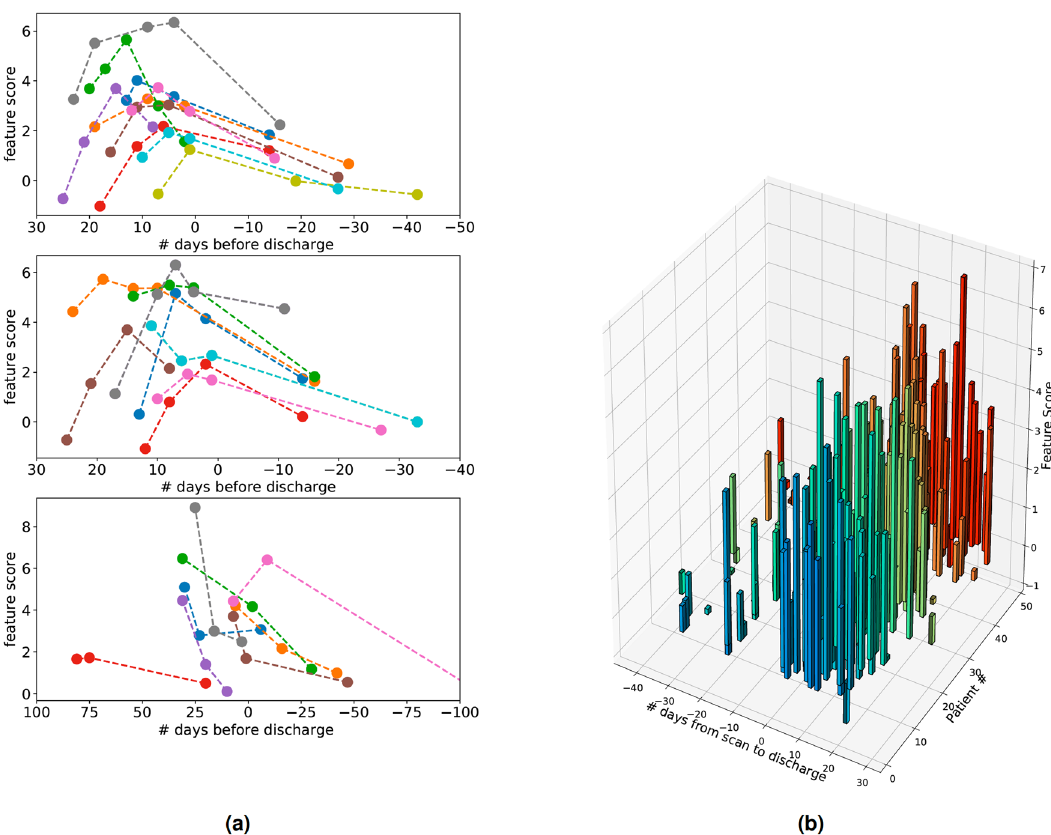
Fig. 10 Features from DCD for the follow-up patients over time. Scans with high scores indicate high similarity to the COVID + PNA population. Many patients show a representative feature trajectory with increasing COVID + PNA intensity peaking near the time of discharge followed by a subsequent decrease after discharge. a Time-series of COVID-19 survivors with 2 or more follow-up scans, and ( b ) 3D plot of selected survivor scores that reveal similar